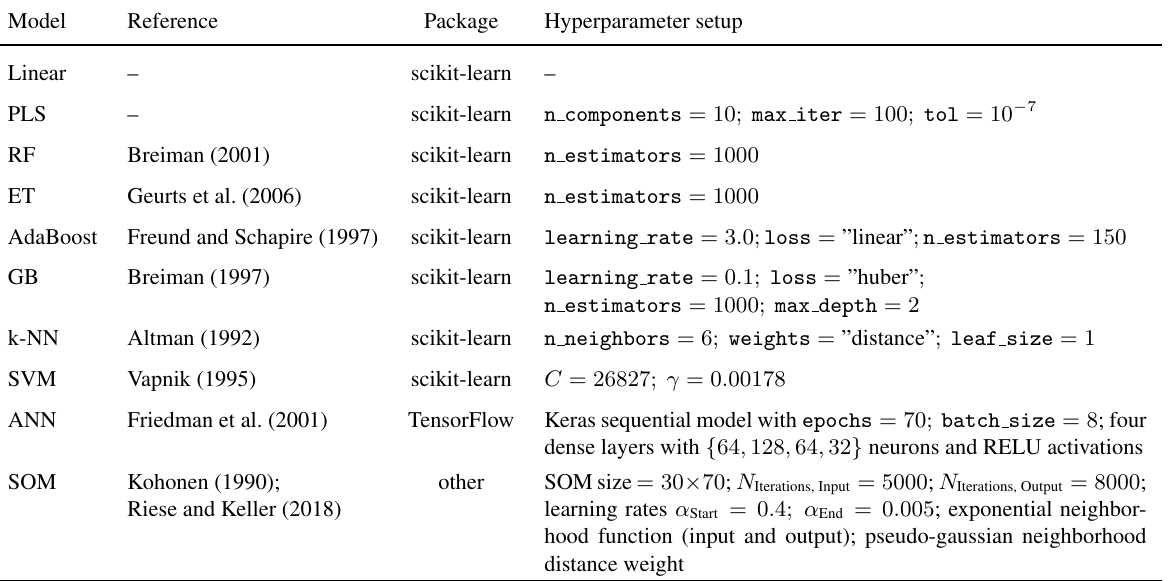
Table 2. Hyperparameter setup for the regression framework without preprocessing. This setup is obtained by a basic grid search algorithm with 10-fold cross validation on the training subset. The regressors are implemented mostly in scikit-learn (Pedregosa et al., 2011) and TensorFlow (Abadi et al., 2016), while the SOM is implemented according to Riese and Keller